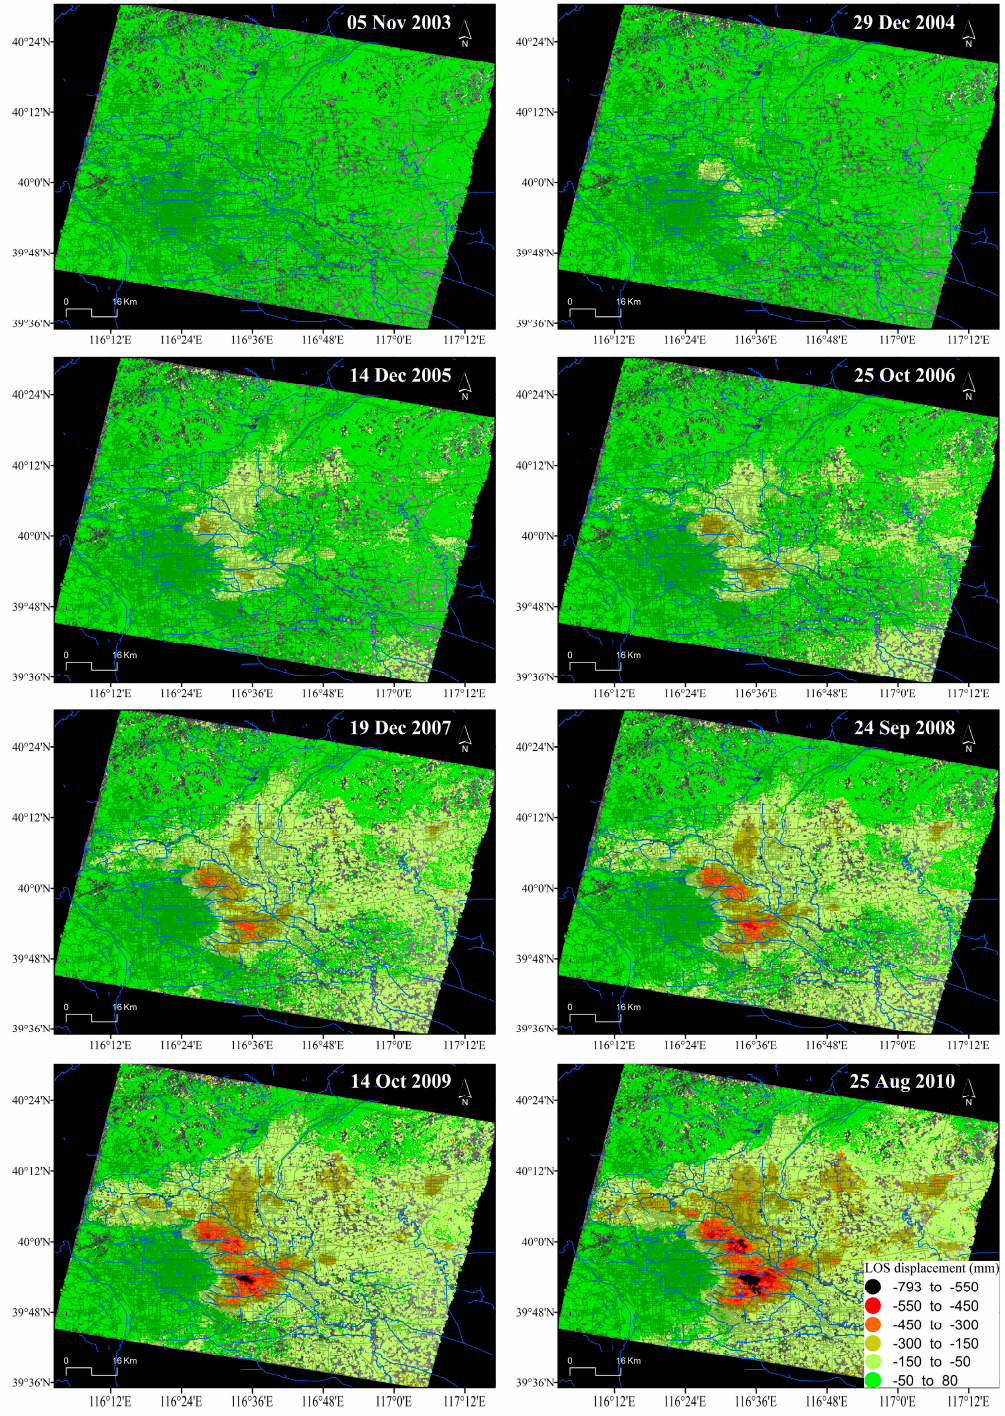
Figure 4. Spatio-temporal evolution of InSAR-derived accumulated LOS displacement in Beijing from Envisat-ASAR images. Note that for simplicity, the displacement patterns of only 8 of the 41 acquisition dates are shown ( i.e. , one per year).